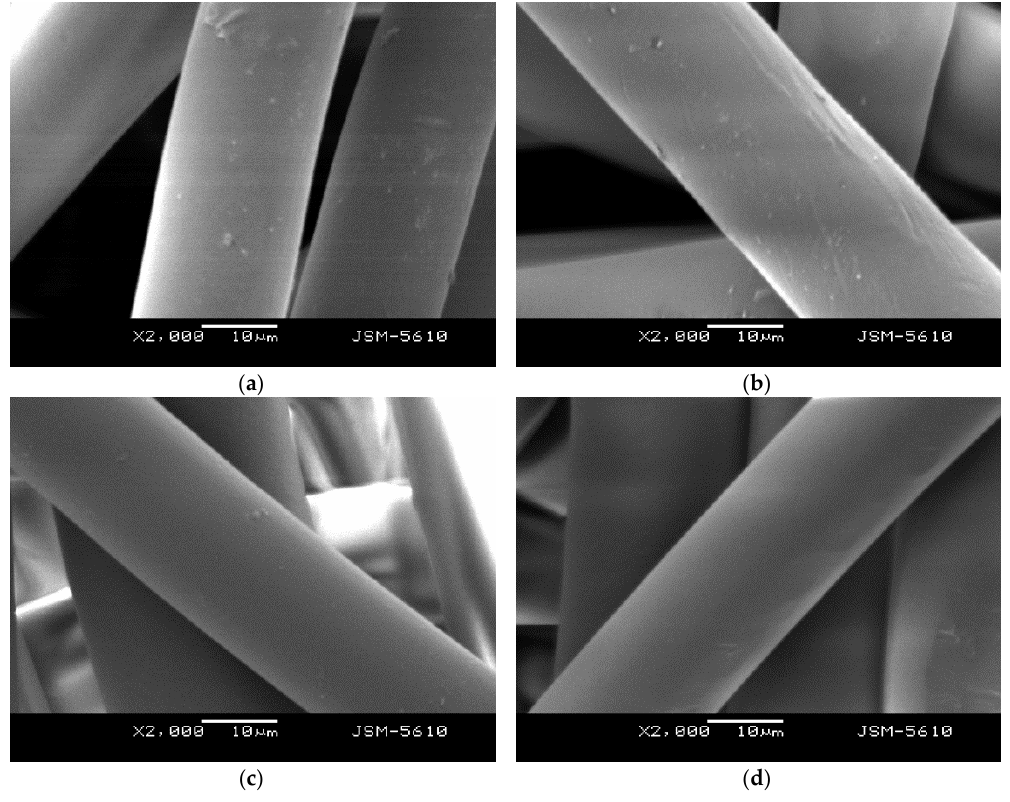
Figure 6. SEM images of the iPP/LMPP blend fibres with ( a ) 9.8 wt LMPP, ( b ) 17.5 wt LMPP and ( c ) 22.5 wt LMPP percentage suggested by the RSM model and ( d ) pure iPP.